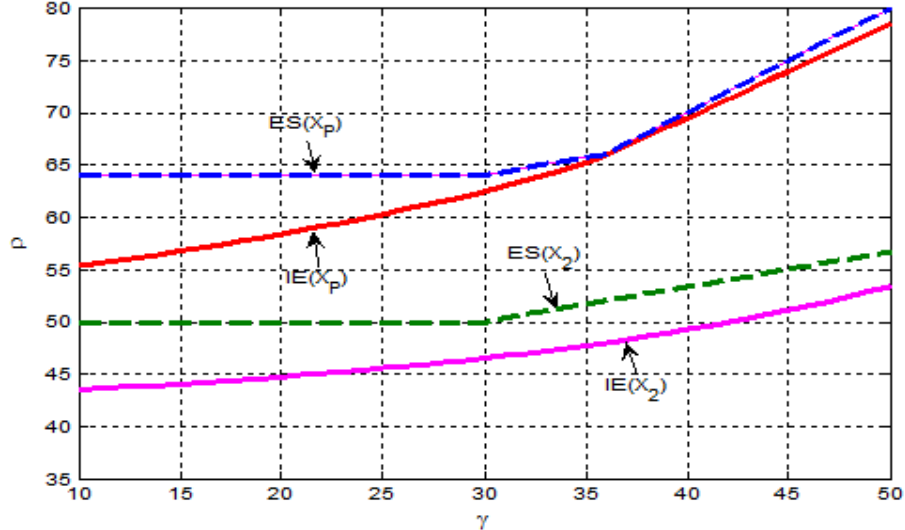
Figure 1. Risk amount dynamics with g based on different risk measures